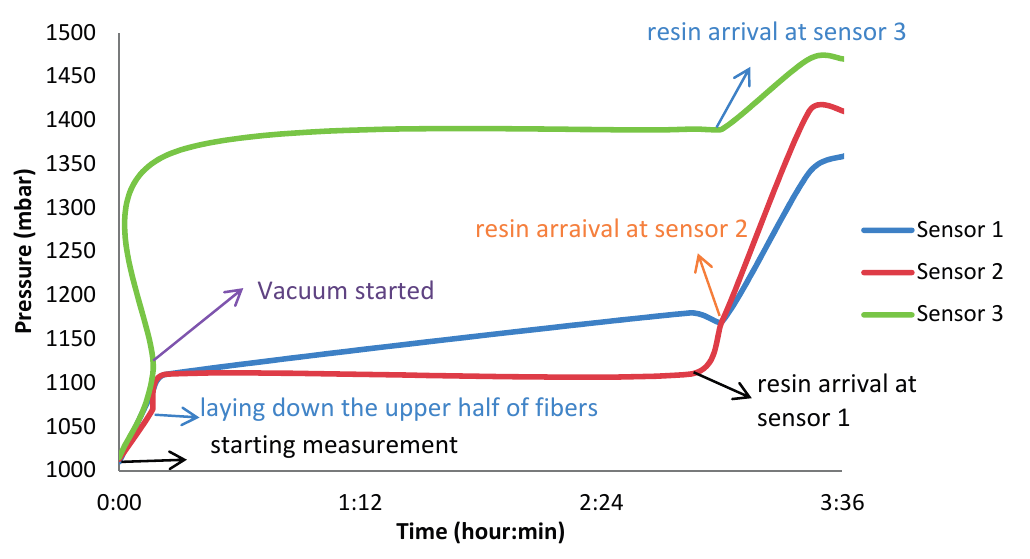
Figure 1. Real-time pressure profile inside the fiber composite laminate, measured by capacitive pressure